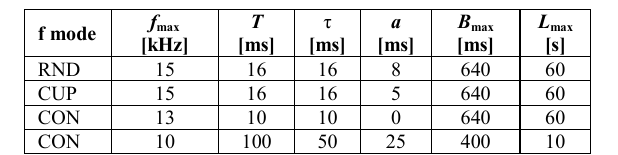
Fig. 6. Example of a waveform captured by the oscilloscope during reservoir testing.